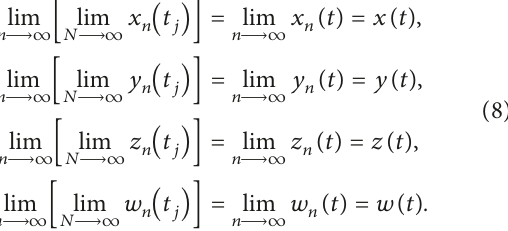
) in x − z − w space; 3